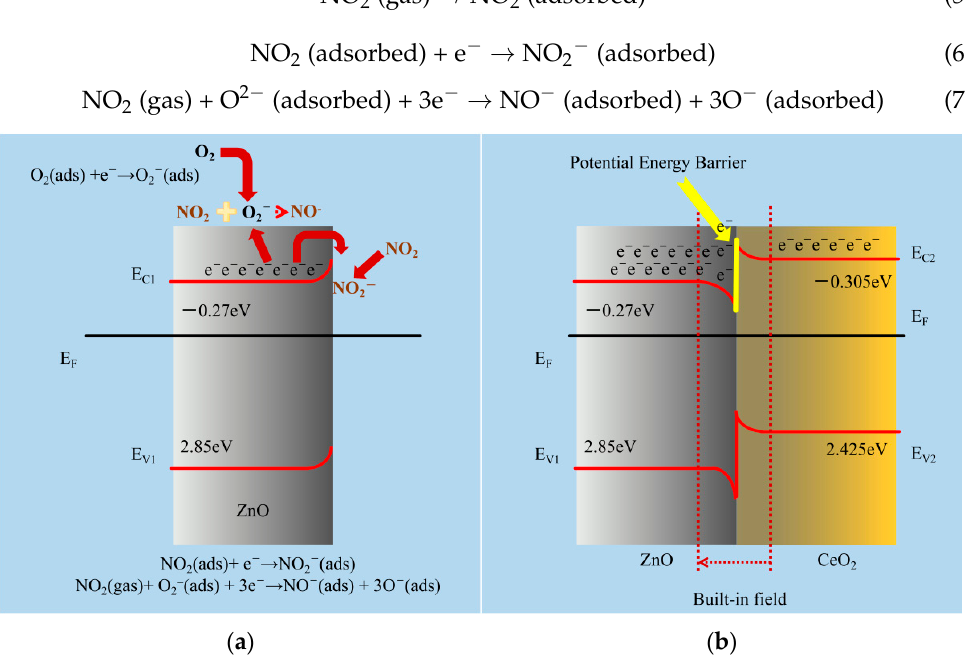
Figure 8. ( a ) The gas-detecting mechanism of the ZnO-based sensors for NO 2 gas is shown schemat- ically. ( b ) Schematic representations of the proposed increased gas-sensing process for CeO 2 /ZnO- based NO 2 sensors. E F is the Fermi level; E C and E V are the conduction and valence band edges, respectively (Table S1).